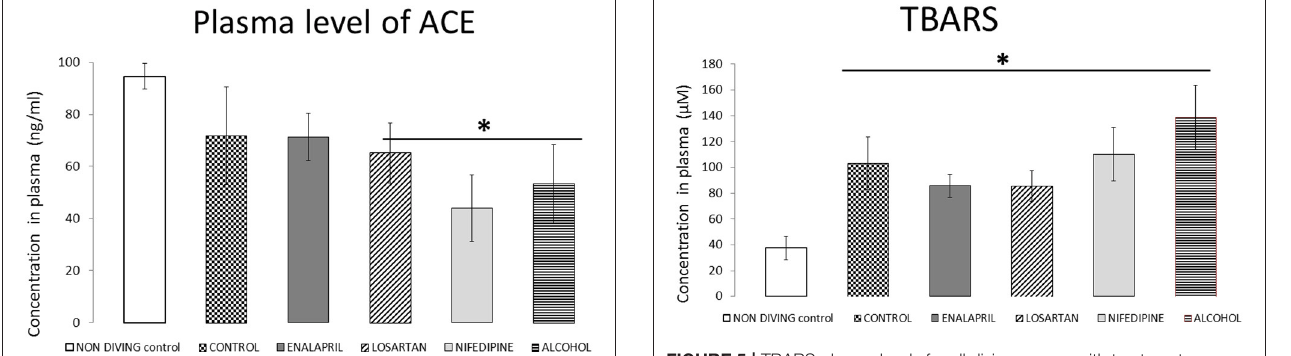
FIGURE 3 | ACE plasma levels for all diving groups with treatment compared with diving control and non-diving rats. ACE plasma levels expressed as ng/ml (mean ± SEM), for all the diving groups with treatment compared with diving control and non-diving rats. * p < 0.05.